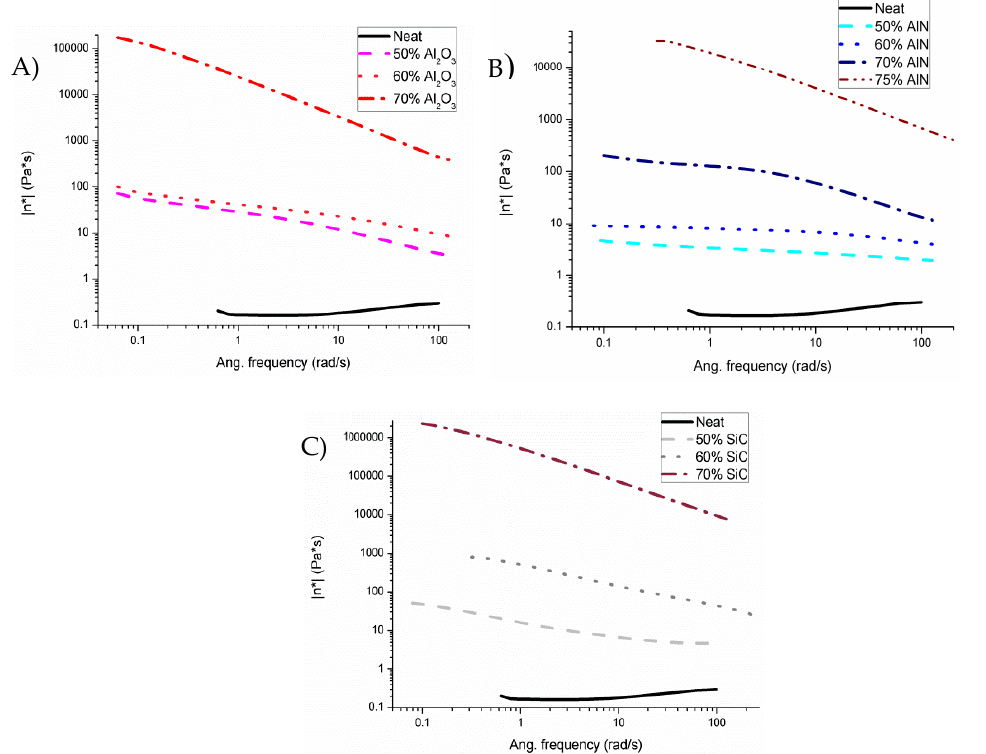
Figure 2. Complex viscosities of mixtures varying frequency in the linear viscoelastic region (LVR) of each formulation at 30 °C with different fillers: ( A ) Al 2 O 3 ; ( B ) AlN; ( C ) SiC.